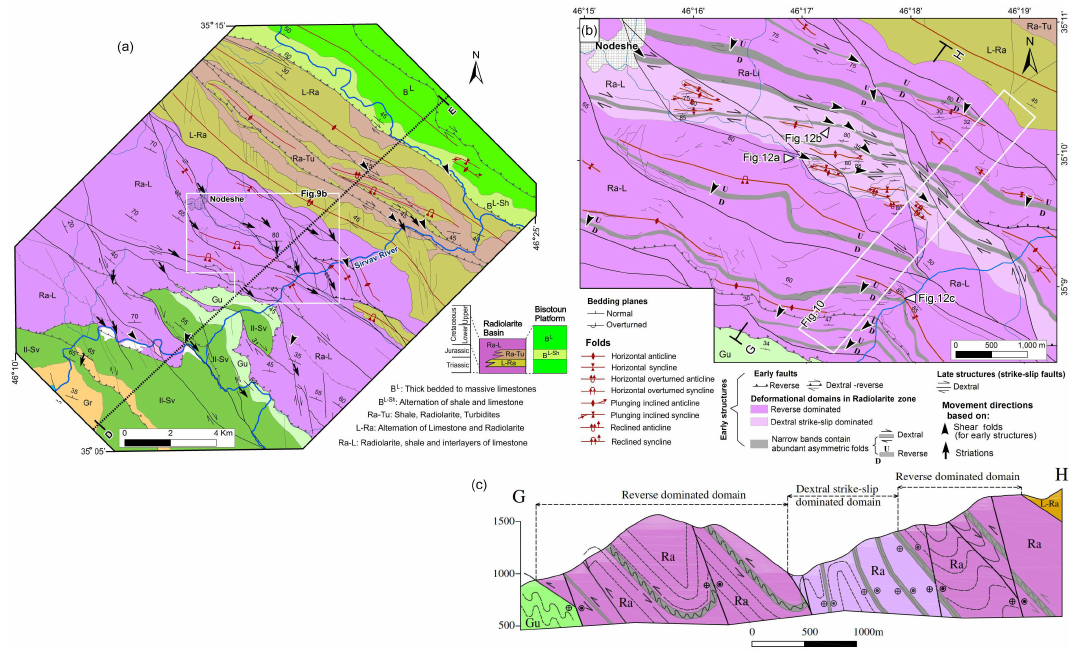
Figure 9. (a) Structural map of a part of the Kermanshah–Sulaimani (KS) area across the Bisotoun, Radiolarite and High Zagros zones. Arrows show movement direction of faults interpreted using asymmetric folds’ striae. See Fig. 6 for the cross section between D and E; (b) simplified structural map of the early structures in the Radiolarite zone near the city of Nodeshe. Location of the figure within the KS area is shown by the white box. Note development of two domains: dextral strike-slip dominated domain, denoted by pink, and reverse dominated domain, denoted by violet; locations of Fig. 10 (by white box) and Fig. 12a, b, c (by white arrows) are shown on the map; (c) structural cross section along the line G–H, shown in Fig. 9b; the black lines are the late strike-slip